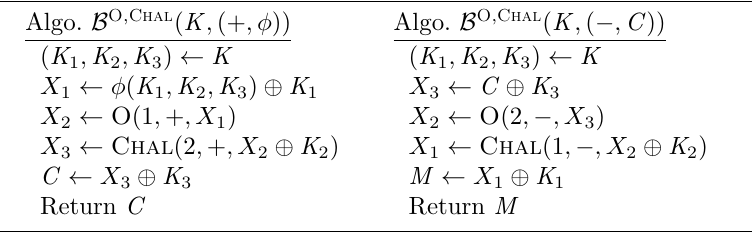
Figure 10: Algorithm B used in the KDM analysis of two-round EM with two